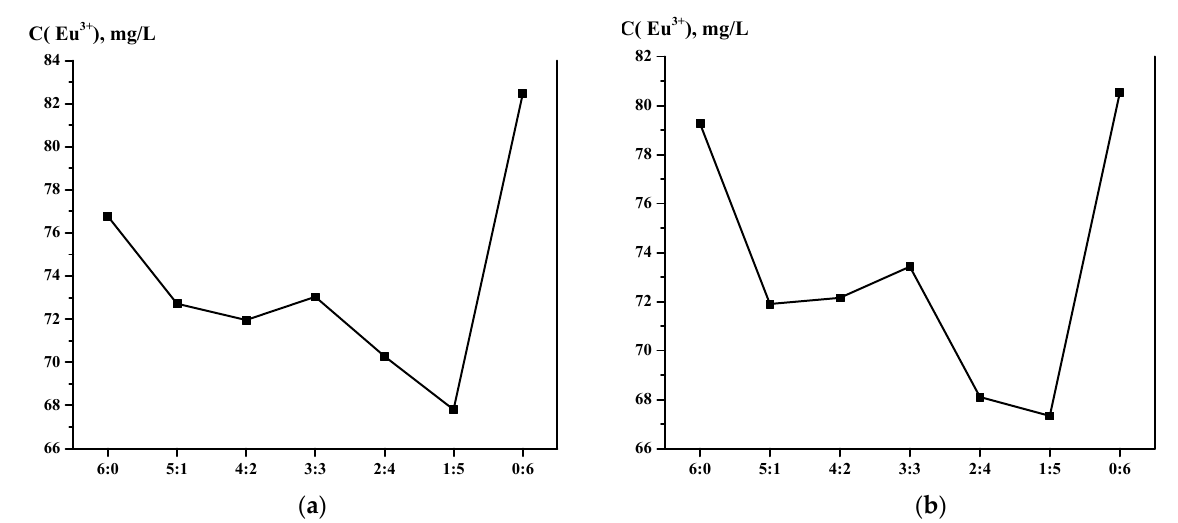
Figure 8. Europium ions concentration at 27 h of remote interaction of Amberlite IR120 and AB-17-8 in interpolymer system: ( a ) atomic-emission spectroscopy; ( b ) photocolorimetry.